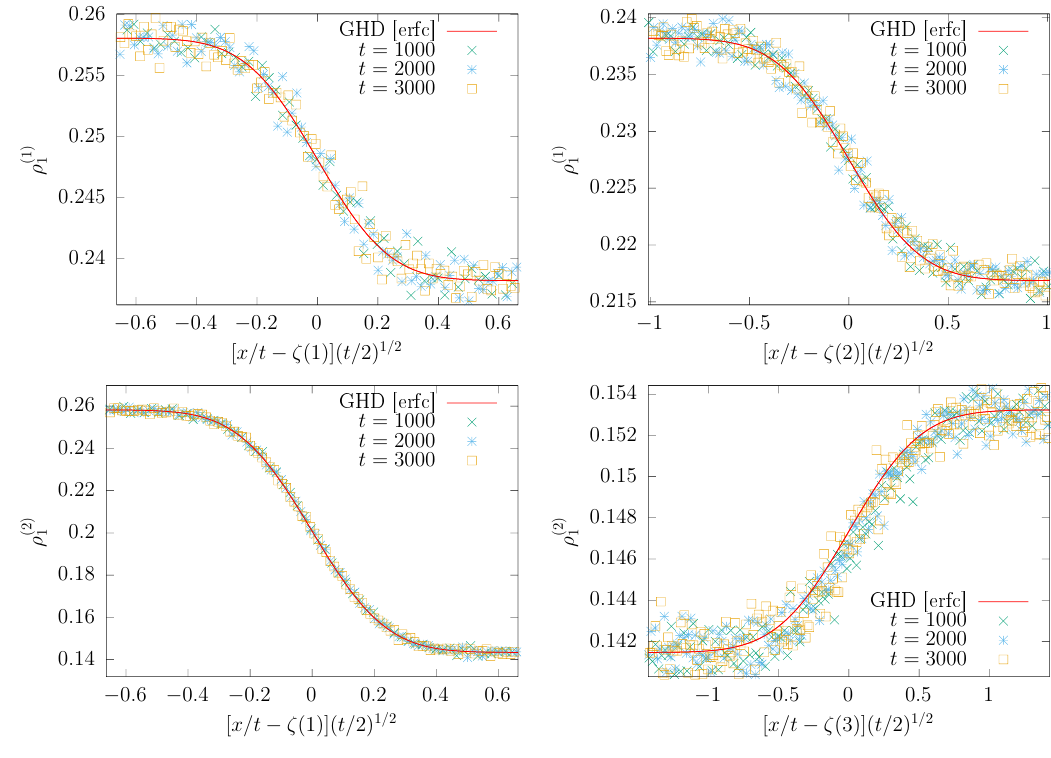
( a ) ( a =1 , 2) Figure 10: Densities ρ of S solitons in the vicinities of the three first steps 1 i =1 (located at x/t = ζ (1) , x/t = ζ (2) and x/t = ζ (3) ) and at three different times. ζ ( k )) t 1 / 2 for the horizontal scale the curves almost collapse With the choice ( x/t − onto each other. This illustrates the diffusive nature of the step broadening. The red curves have been obtained without any free parameter (no fit) and represent the GHD prediction. They take the form of a complementary error function (see Sec. 5.2 and (5.19)). Initial state fugacities: z 1 ,L = 1 z 2 ,L = 0 . 7 and z 3 ,L = 0 . 3 , z 1 ,R = 1 z 2 ,R = 0 . 9 and z 3 ,R = 0 . 1 . System size L = 1 . 210 6 . Number of random initial condi- = 400000 . This simulation represents (2 L ) N t max 0 . 3 10 16 tions N samples samples · · · ∼ · applications of the combinatorial R